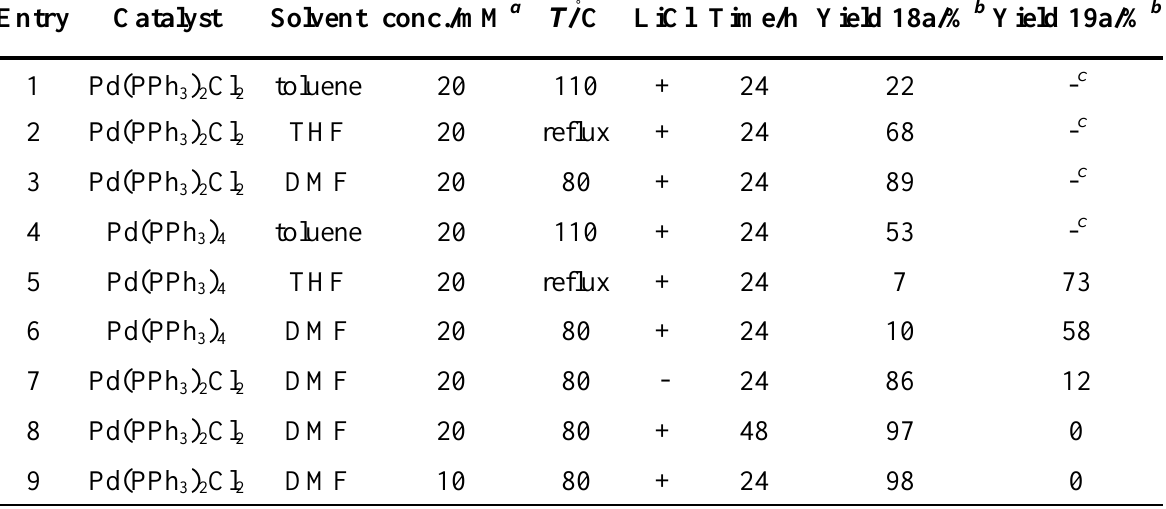
Table 4. Optimization of the Stille cross-coupling reaction parameters between 15a and 16